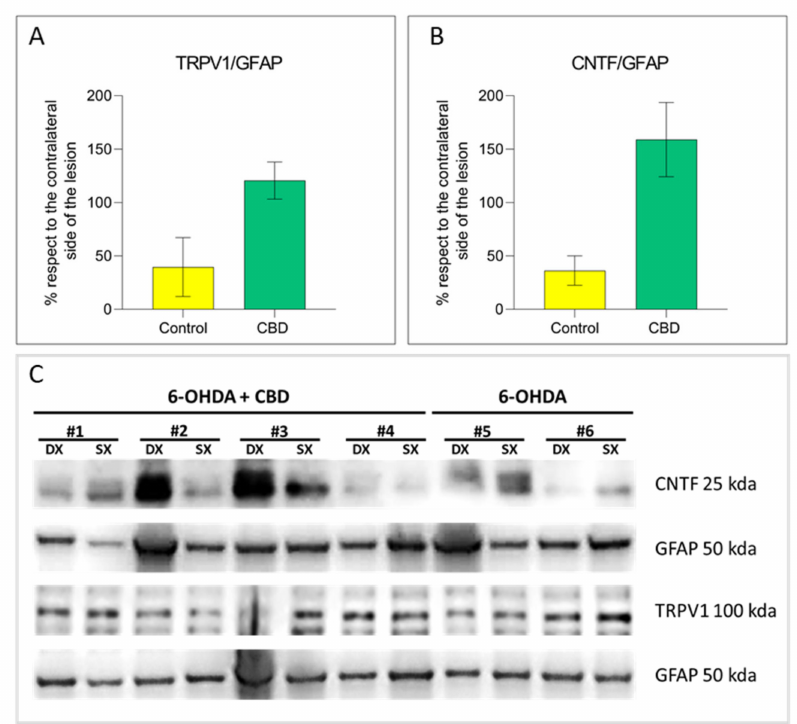
Figure 7. TRPV1 and CNTF astrocytic expression in the substantia nigra. ( A ) Quantification of TRPV1 expression in astrocytes. ( B ) Quantification of CNTF expression in astrocytes. ( C , D ) Representative images of Western Blot for TRPV1, CNTF and GFAP expression in the lesioned (Dx) and unlesioned (Sx) SNc, in both experimental groups. Results are expressed as mean ± SEM. N = 2 to 4 in each